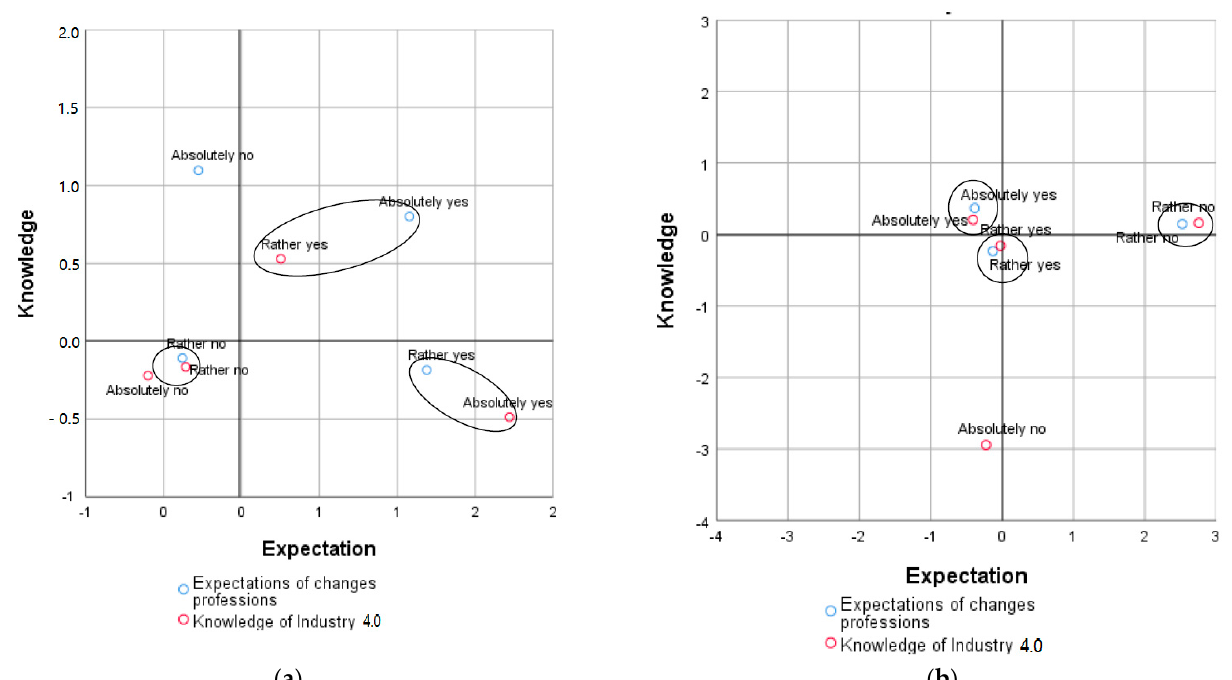
Figure 3. Relations between expectation and knowledge of Industry 4.0 in ( a ) the Czech Republic, ( b ) Germany.